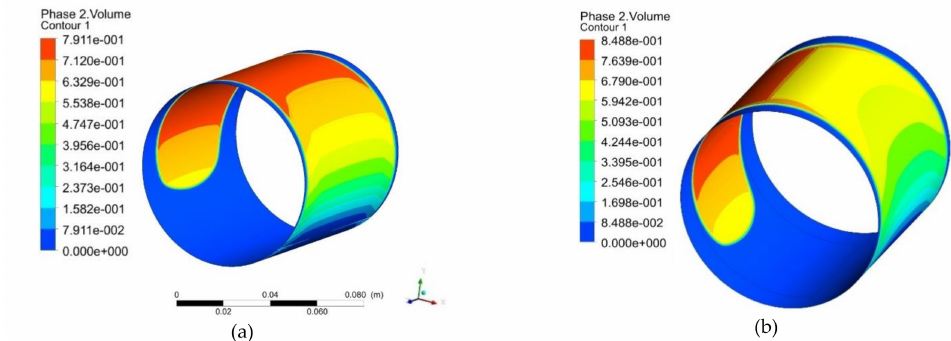
Figure 12. Comparison of the contour of vapor volume fraction between ( a ) the conventional (no-slip) bearing and ( b ) the heterogeneous slip/no-slip bearing. All results are evaluated at n = 3000